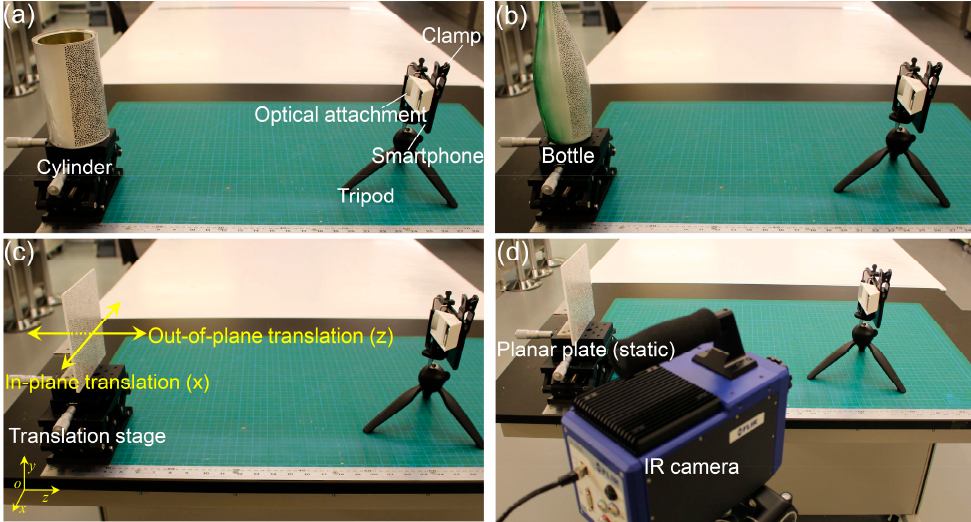
Figure 3. Experimental set-up for validating the effectiveness, accuracy and stability of the established smartphone-based stereo-DIC system: ( a , b ) Shape measurements of the regular cylinder and bottle surfaces, ( c ) in-plane and out-of-plane displacement measurements of a translated planar plate, and ( d ) a static test with the imaging system and planar plate both kept static.